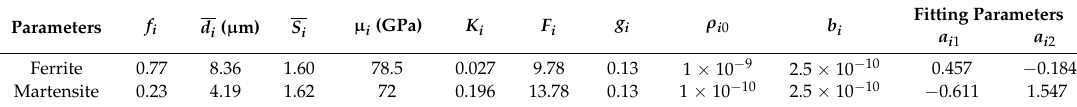
Figure 7. The metallographic figure of sample 3 with different overall strain during in situ tensile test, ( a ) ε = 0.026, ( b ) ε = 0.072, ( c ) ε = 0.126, and ( d ) ε = 0.157. Table 3. Parameters of DP600